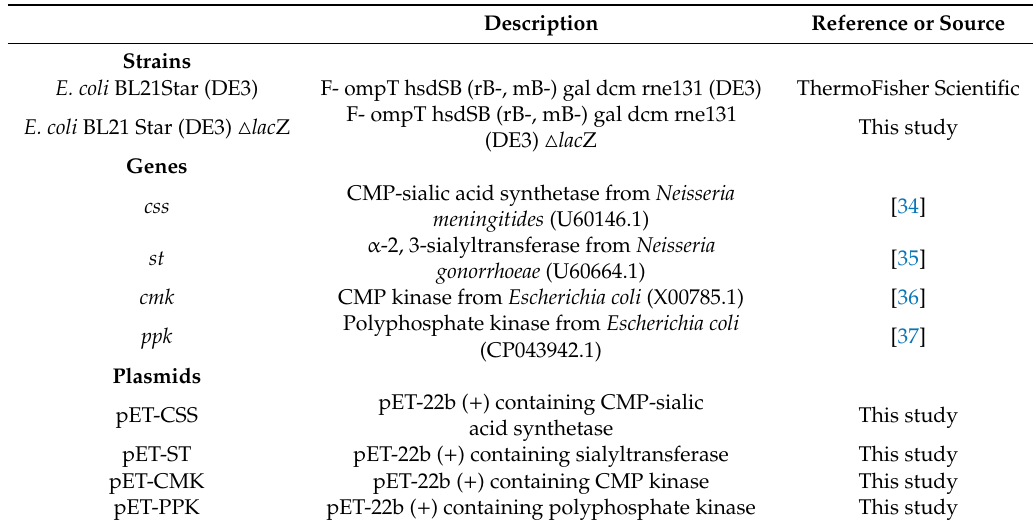
Table 1. Strains, genes, and plasmids used in the